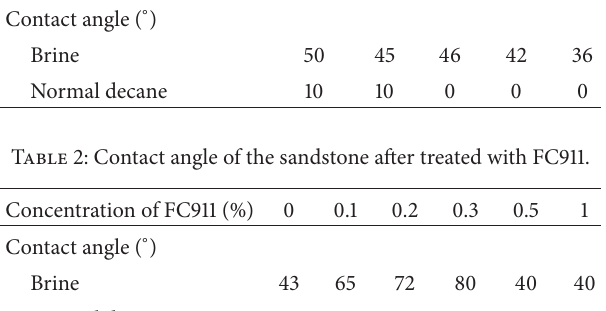
Table 1: Contact angle of the sandstone after treated with FG1105. Concentration of FG1105 (%)